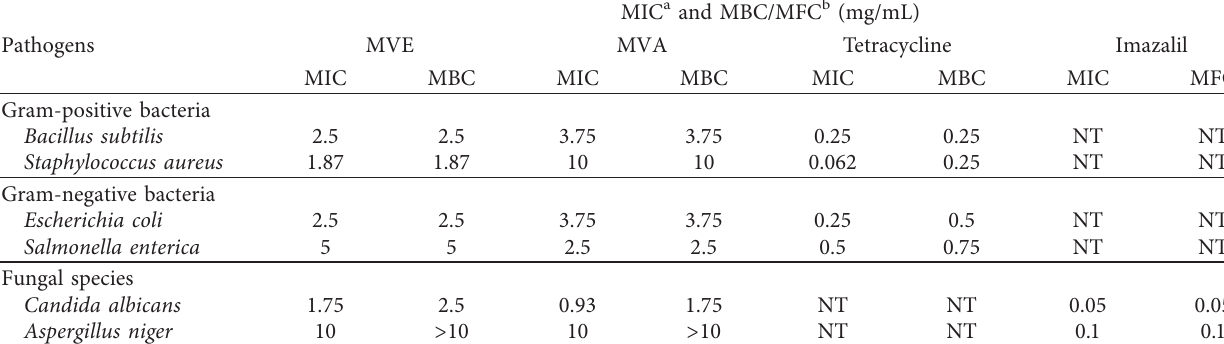
Table 4: MICs and MBC/MFCs (mg/mL) of MVE and MVA